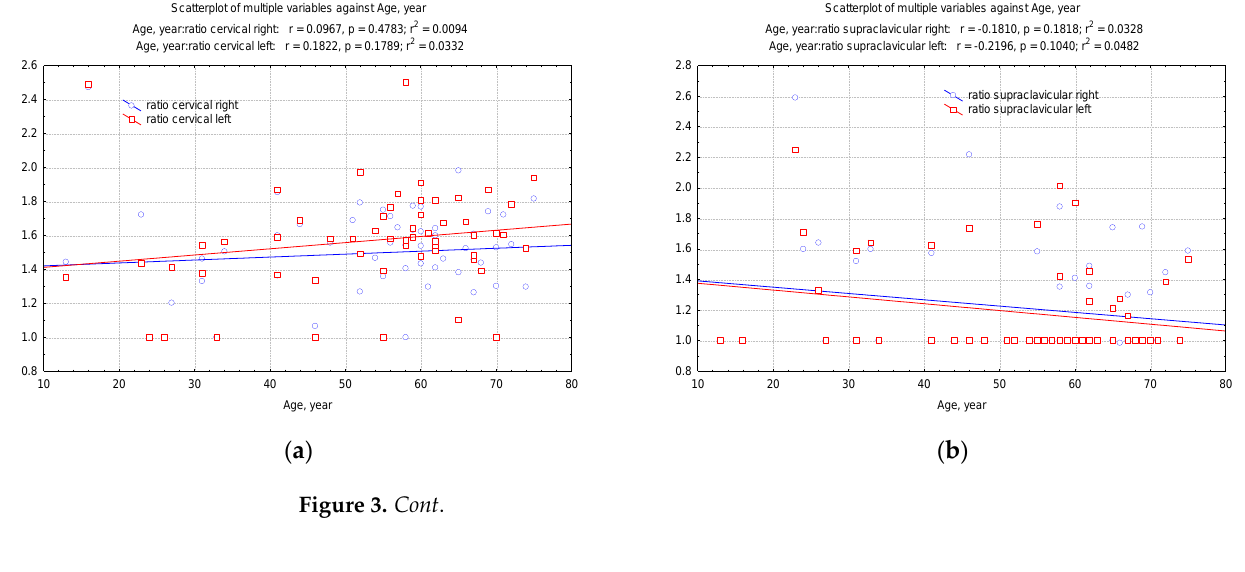
Figure 2. Histograms for the values of (total counts/pixels) BAT / (total counts/pixels) non-BAT ratio in the cervical ( a , b ) and supraclavicular localizations ( c , d ). ( A ratio of 1 is obtained when BAT is not activated in the concerned localisation: ( total counts/pixels) BAT = (total counts/pixels) non-BAT ). The correlations between this BAT ratio and the demographic aspects showed a sig- nificant relation between the right and left cervical BAT ratios and the BMI values (the increase in BMI was followed by the increase in right and left cervical BAT ratios; r = − 0.299, p = 0.014 on the right; r = − 0.295, p = 0.014 on the left) (Figure 3). Scatterplot of multiple variables against Age, year Age, year:ratio supraclavicular right: r = -0.1810, p = 0.1818; r 2 = 0.0328 Age, year:ratio supraclavicular left: r = -0.2196, p = 0.1040; r 2 = 0.0482